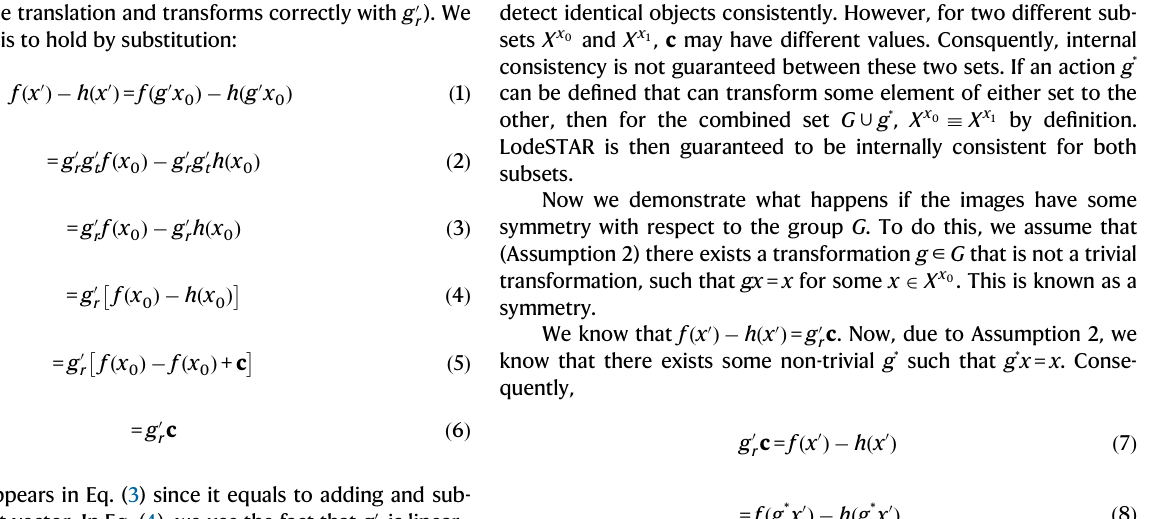
Fig. 6 | LodeSTAR measurement of particle polarizability exploiting signal strengthsymmetry.a Realandimaginarypartofasimulatedholographicimageof a sphere (radius 228nm, refractive index 1.58), ( b ) their versions with numerically rescaled signal strengths. c Despite being trained on a single particle (radius 228nm, refractive index 1.58), the mean absolute percentage error (MAPE) of the predicted polarizability remains below 10% for a wide range of particle sizes and refractive indices. d In an experimental bi-dispersed sample, LodeSTAR accurately estimatesthepolarizabilityof the150nmpopulationofpolystyreneparticles(pink histogram), even though it is trained on an image from the 228nm population (orange histogram). e The imaginary part of a position-modulated holography image of fl uorescent polystyrene particles (radius 225nm) suspended inside and